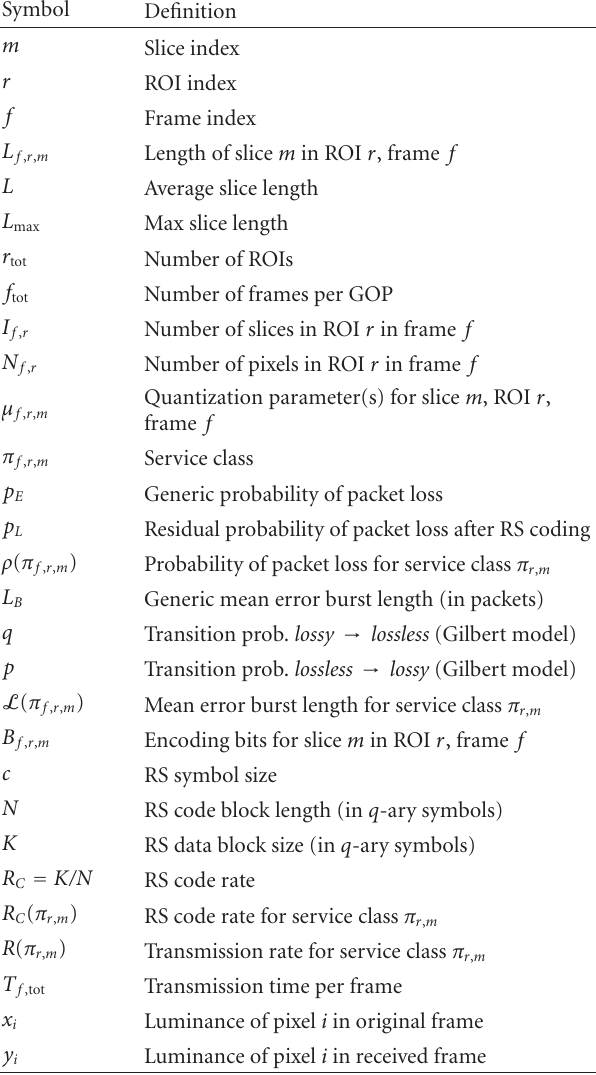
Table 1: Summary of important symbols